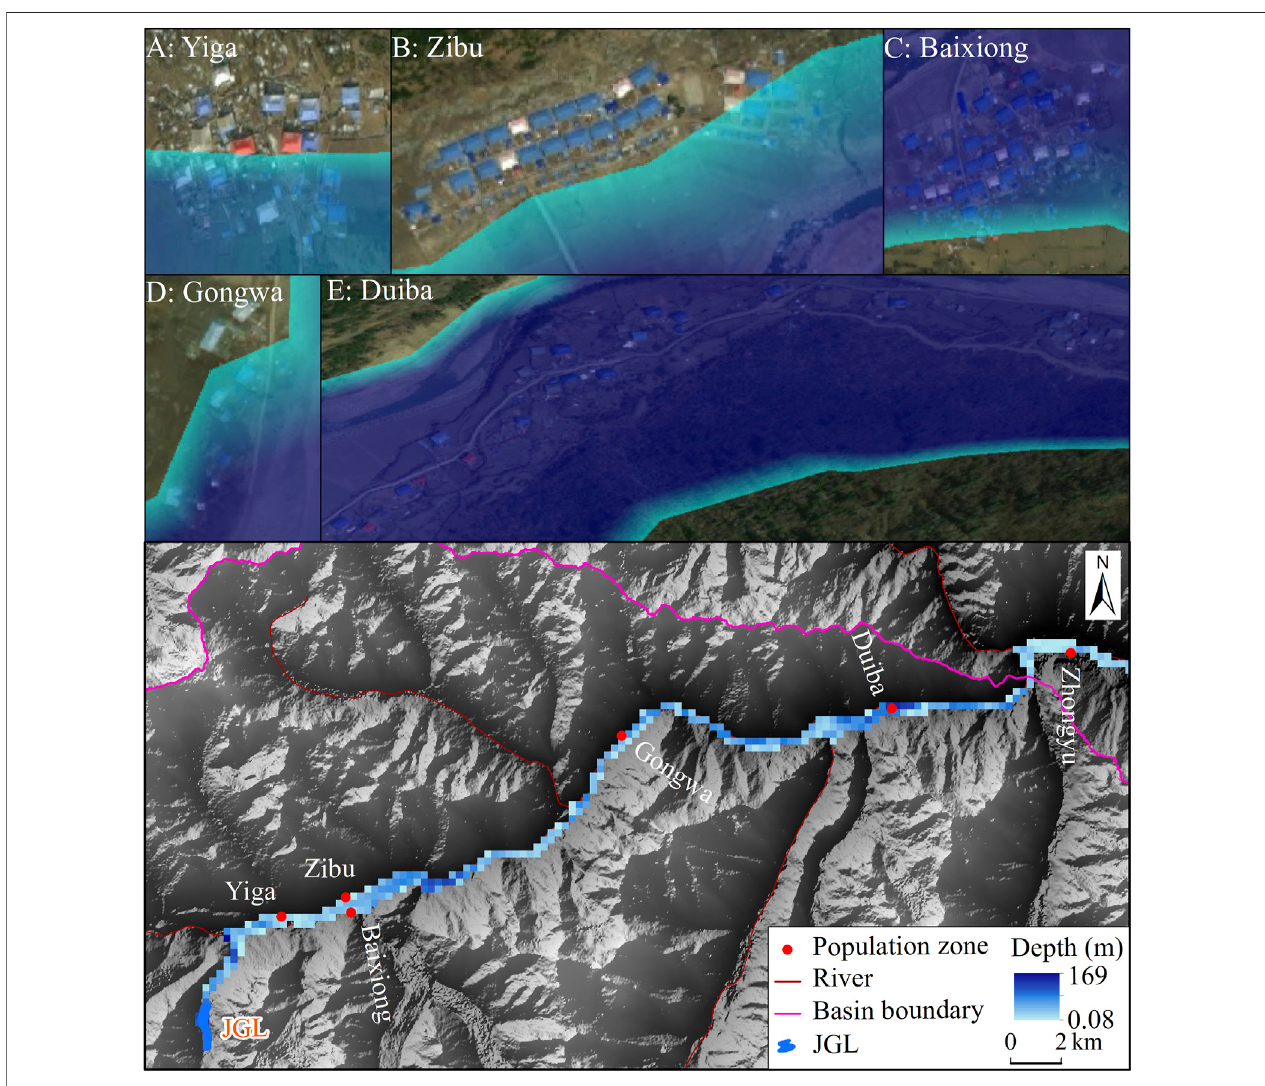
FIGURE 8 | Maximum depth along the Niduzangbo river channel. Sub fi gure (A) – (E) are spatial distribution of maximum depth in different villages.